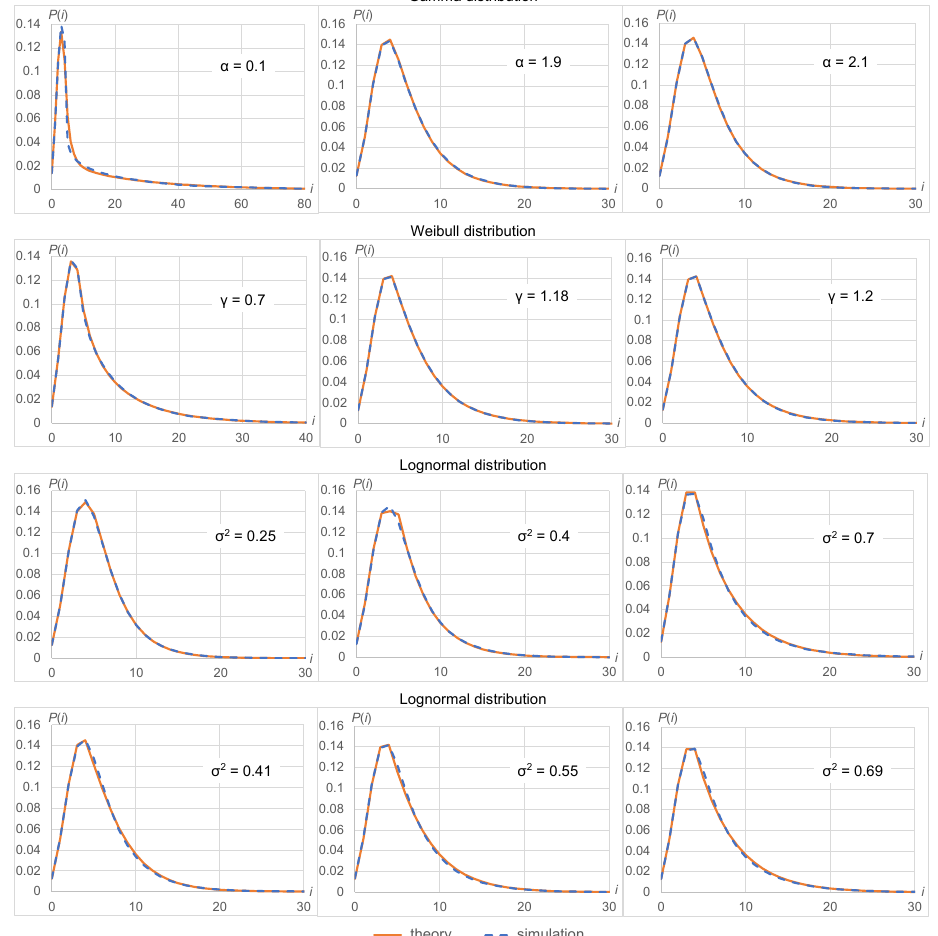
Figure 2. PMFs obtained by the approximation and simulation for multi-server queue with various distributions of service time and their